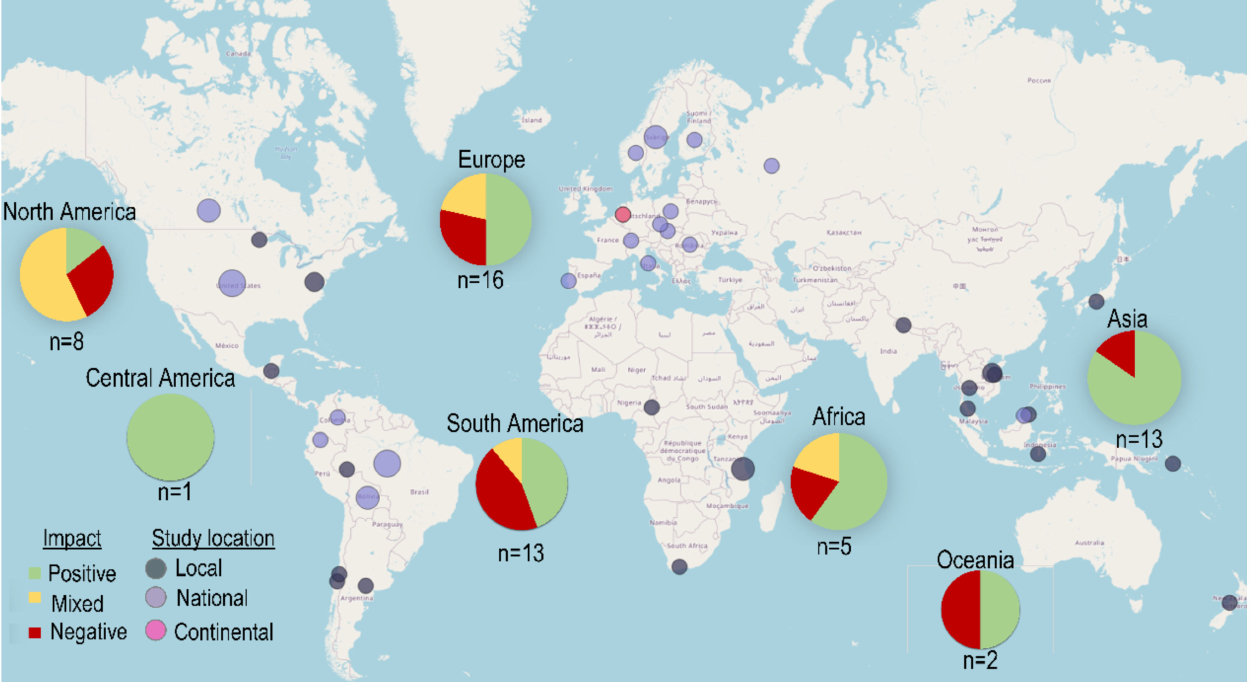
Figure 10. Global distribution of case studies on the impact of forest certification on economic viability. The size of the dots represents the relative amount of case study per location. Study location: Local studies are here equal or smaller than districts/states. National studies indicate that multiple study sites or enterprises across the country were investigated. Continental studies include studies conducted on the scale of a political union (i.e., EU). Pie charts show the number of case studies and the reported impact per region. Base map: ©